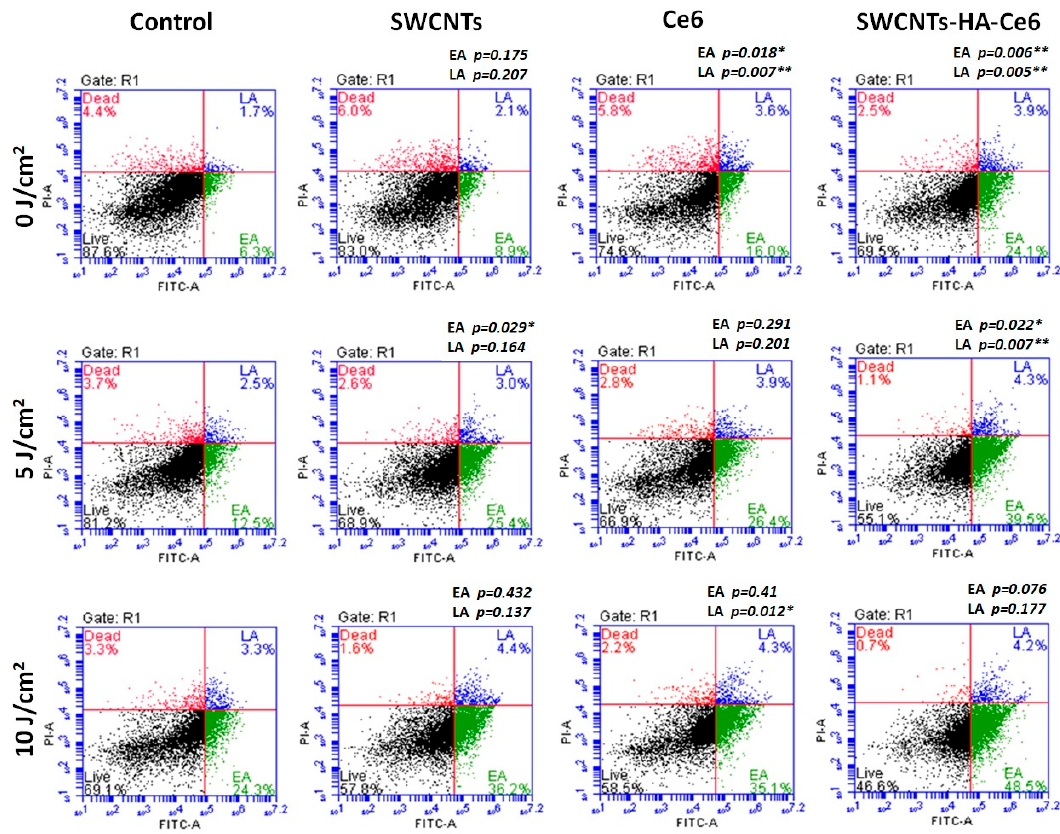
Figure 7. Flow cytometry Annexin V PI staining analysis of apoptosis.